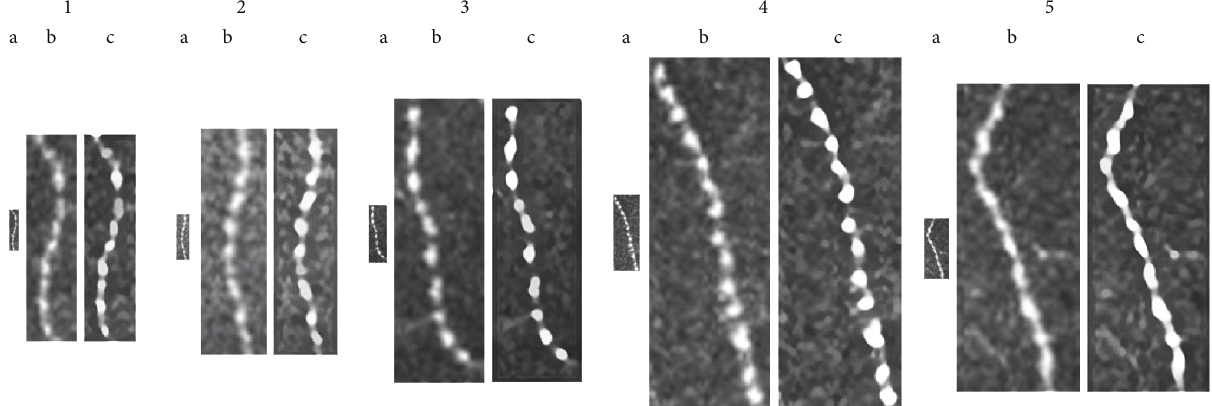
Figure 2: The representative beads in the original CCM images (a), images simply magnified 5 times by Photoshop (b), and images enlarged 5 times with smoothing by the S-Spline Max algorithm (c) in a control subject (1, male, 56 years, NDS: 0), patient without neuropathy (2, male, 52 years, NDS: 1), patient with mild neuropathy (3, male, 54 years, NDS: 5), patient with moderate neuropathy (4, male, 56 years, NDS: 7), and patient with severe neuropathy (5, male, 57 years, NDS: 9). Table 3: Differentiating efficacy of corneal nerve fiber parameters as AUC and 𝑝 values with CCM cut-off with sensitivity and specificity between control subjects and type 2 diabetic patients without neuropathy or between type 2 diabetic patients with or without neuropathy. Between control subjects and type 2 diabetic Between type 2 diabetic patients without or Variable patients without neuropathy with neuropathy AUC 𝑝 value Cut-off Sensitivity Specificity AUC 𝑝 value Cut-off Sensitivity